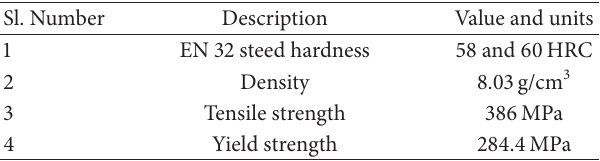
Table 4: Properties of the counterface material. Sl. Number